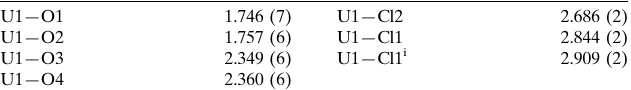
Selected interatomic distances (A˚